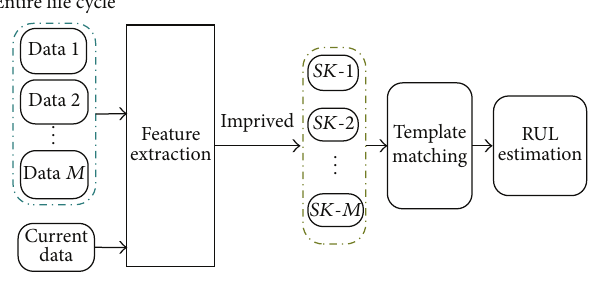
Figure 4: Framework of the RUL estimation.